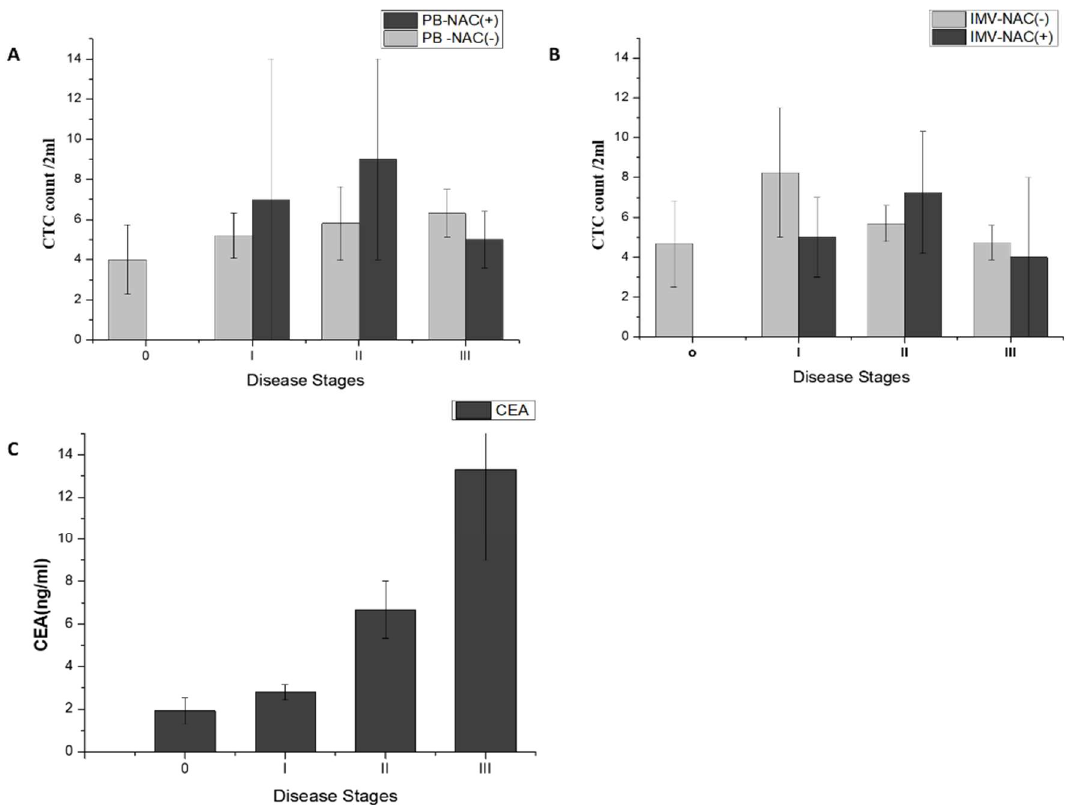
Figure 3. Analysis of the relationships between disease stage and blood biomarkers, stratified by the presence or absence of neoadjuvant chemotherapy (NAC). ( A ) Peripheral vein blood (PB) and clinical staging analysis of NAC(−) and NAC(+) patients; ( B ) Inferior mesenteric vein blood( IMV) and clinical staging analysis of NAC(−)and NAC(+) patients; ( C ) the carcinoembryonic antigen( CEA) concentrations and disease stages.